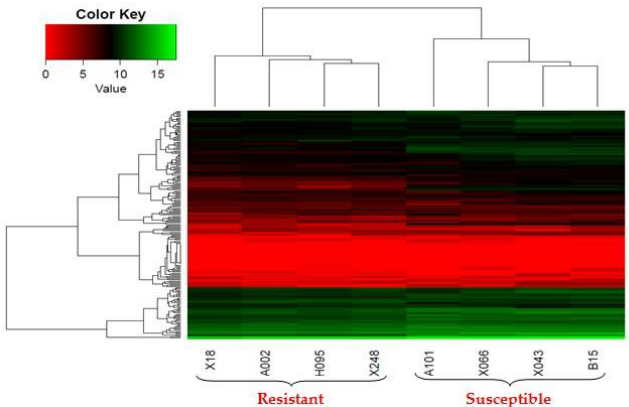
Figure 2. Differentially expressed genes (DEGs) between resistant and susceptible YWGs. Heatmap of standardized reads-count in eight samples of resistant and susceptible goats. Each row represents genes and the column represents samples (resistant and susceptible goat IDs), and the color key values (0 to 15 scale) shows sequentially minimum to maximum expression.